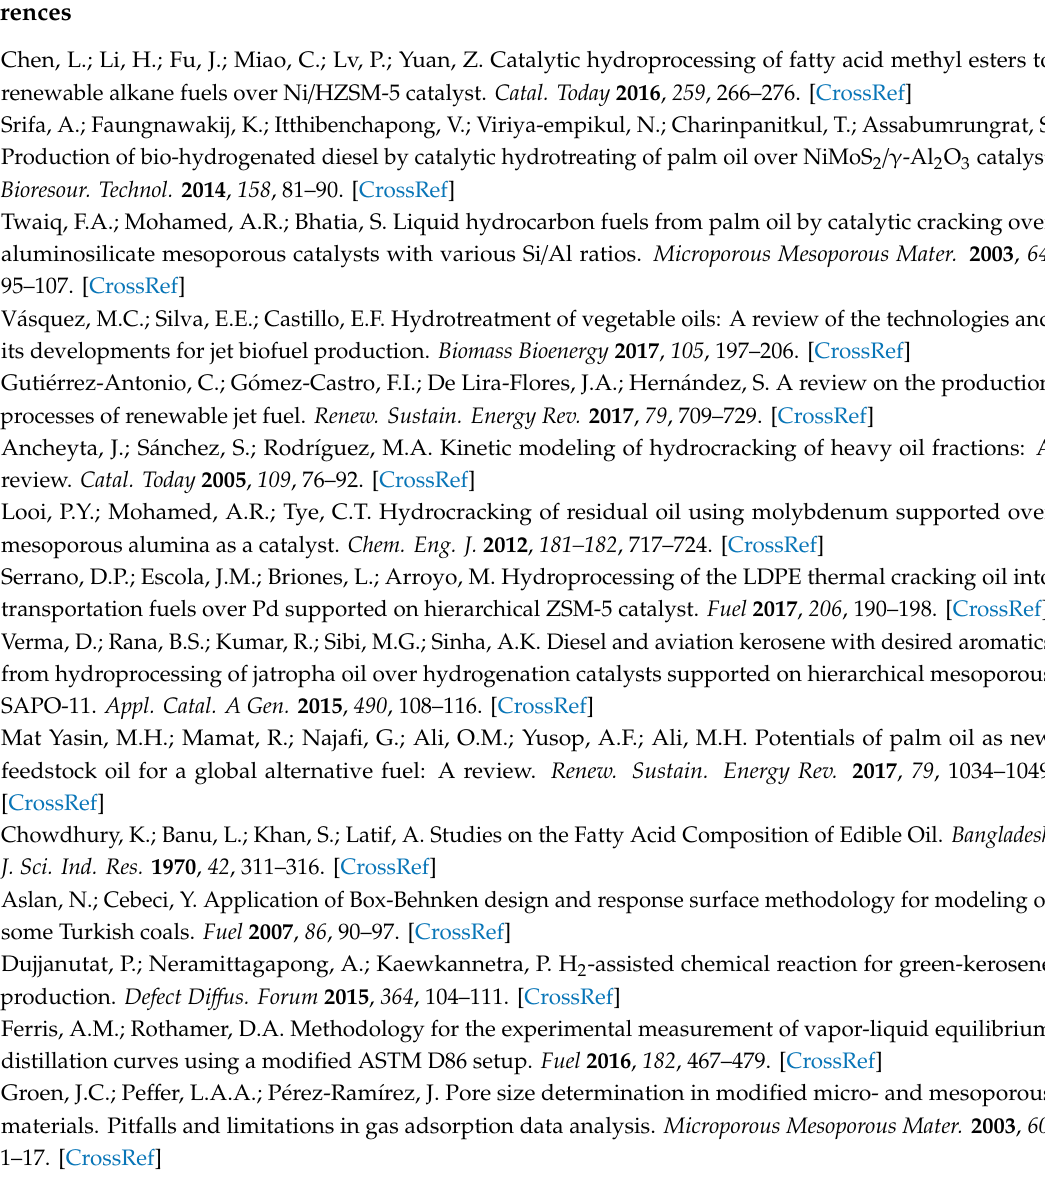
Figure S1: Residual plots of kerosene selectivity, Figure S2: Experimental and estimated results for kerosene selectivity, Figure S3: Optimal plot of kerosene